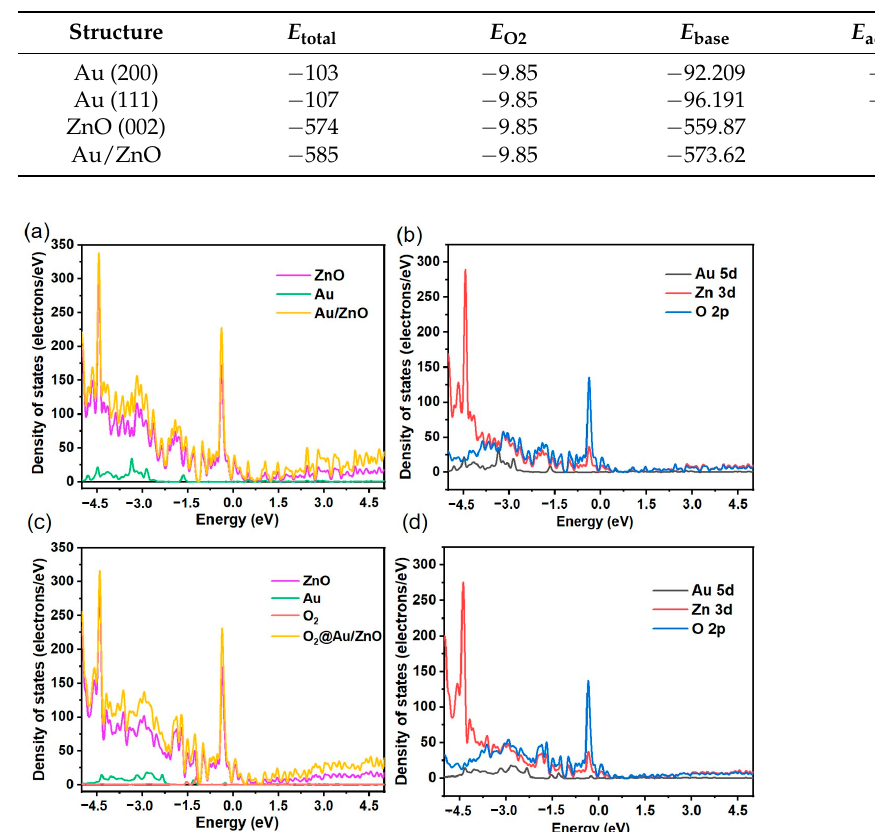
Figure 11. Optimized configurations of O 2 molecule adsorption on ( a ) Au (200), ( b ) Au (111), and ( c ) ZnO (002) surface. Table 2. The calculated adsorption energies of O 2 on various surfaces.